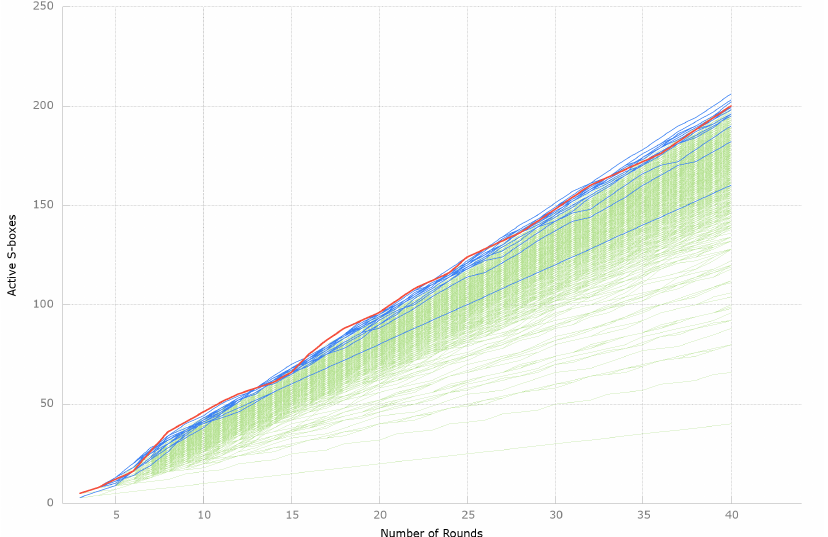
Figure 4: Bounds on the number of active S-boxes for the original Skinny permutation (red), the permutations which reach at least once the optimal bound for 7 ≤ r ≤ 40 after filtering them for diffusion (blue) and a random sample of 10000 permutations after filtering them for diffusion (green). There might be permutations attaining better bounds, but having worse